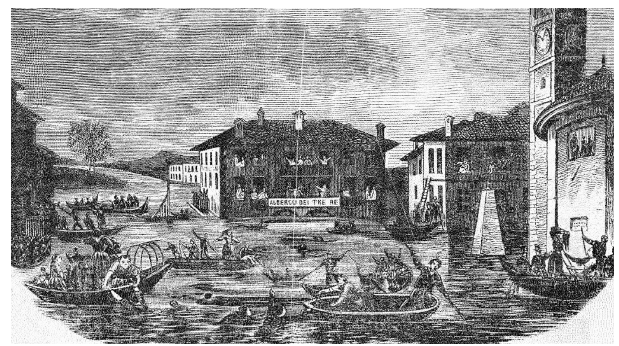
Figure 1. Engraving showing the historical center of Sesto Calende, located at the southern end of Lago Maggiore (see label in Fig. 2), during the 1868 flood event. Taken from Bogni